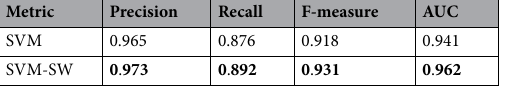
Table 2. Performance comparison on SVM and SVM-SW.